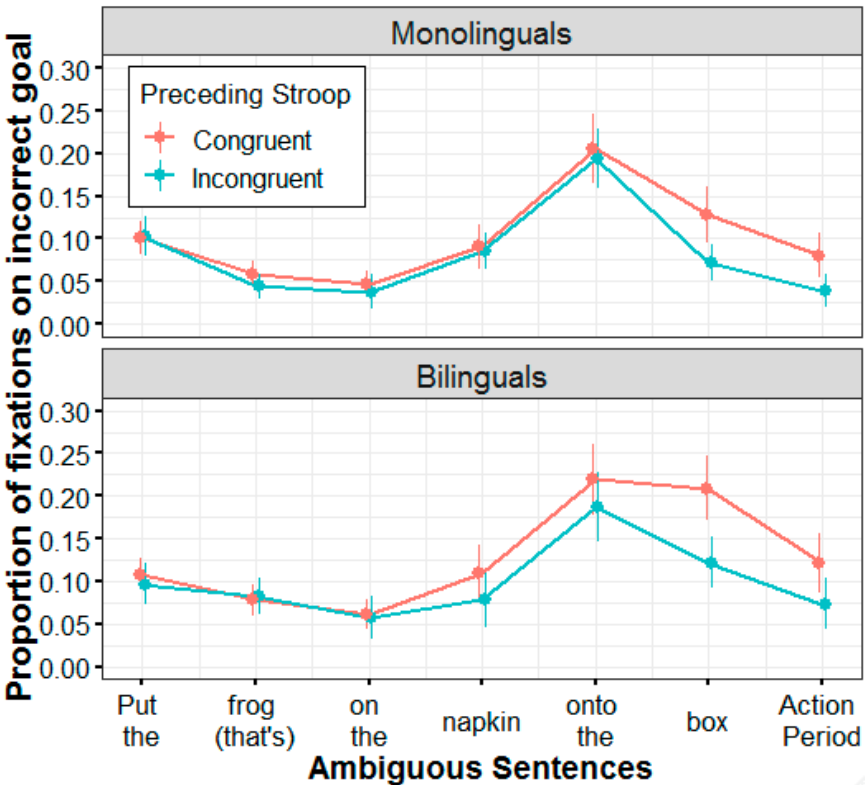
Figure 4. Mean proportion of fixations on the incorrect goal over time for ambiguous sentences as a function of preceding Stroop trial type. Higher values on the y -axis indicate more looks to the incorrect goal. Colored error bars indicate 95% confidence intervals.